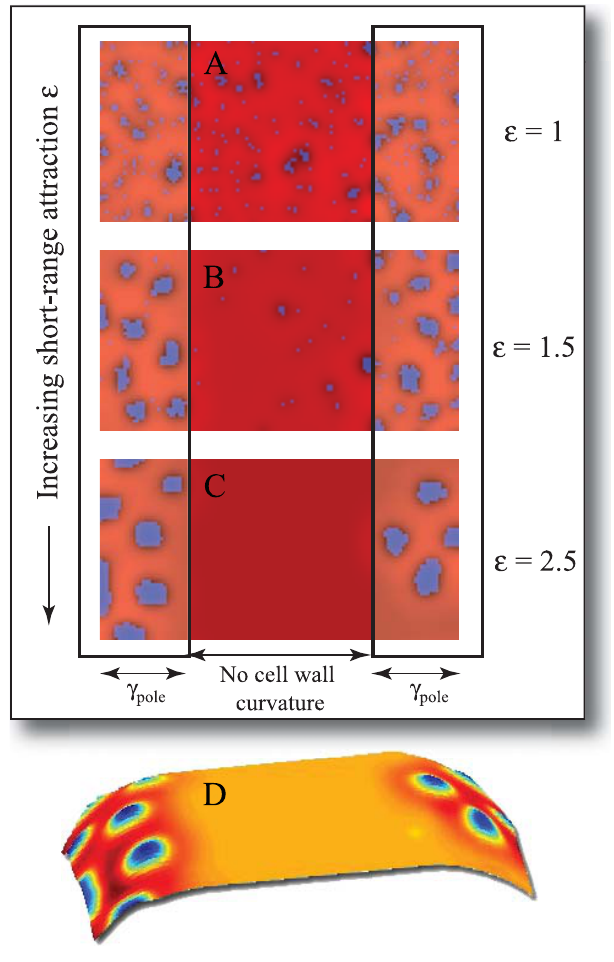
Figure 3. Polar Localization of Lipid Clusters Elastic energy parameters are fixed ( j ¼ 25 k B T, k ¼ 0.25 k B T /nm 4 , c ¼ 0.4 nm (cid:1) 1 ), with varying short-range attraction (A) e ¼ 1 k B T, (B) e ¼ 1.5 k B T, and (C) e ¼ 2.5 k B T . The rectangles on the left and right represent the cell poles and have slightly enhanced cell-wall curvature, c pole ¼ 0.04 nm (cid:1) 1 . The three-dimensional figure in (D) represents the lipid position and the membrane height in (C) mapped onto the surface of a capped cylinder. The color scheme and fraction of lipid A ( u ¼ 0.075) are the same as in Figure